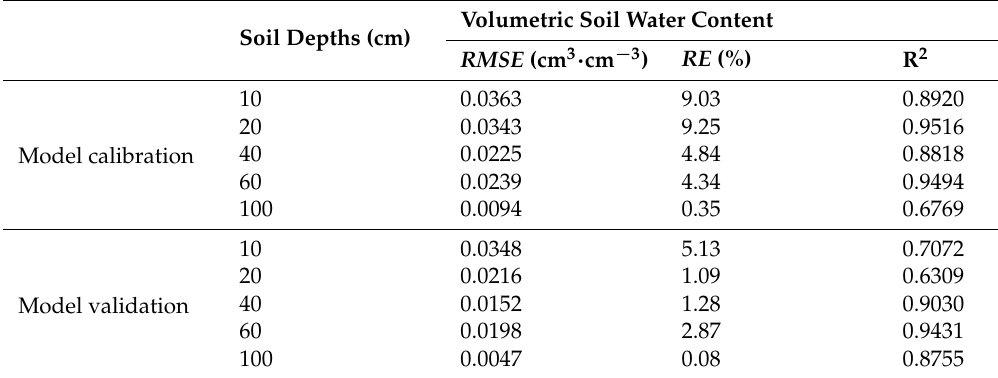
Table 5. The root mean square error ( RMSE ), mean relative error ( RE ) and coefficient of correlation (R 2 ) between the simulated and observed soil water